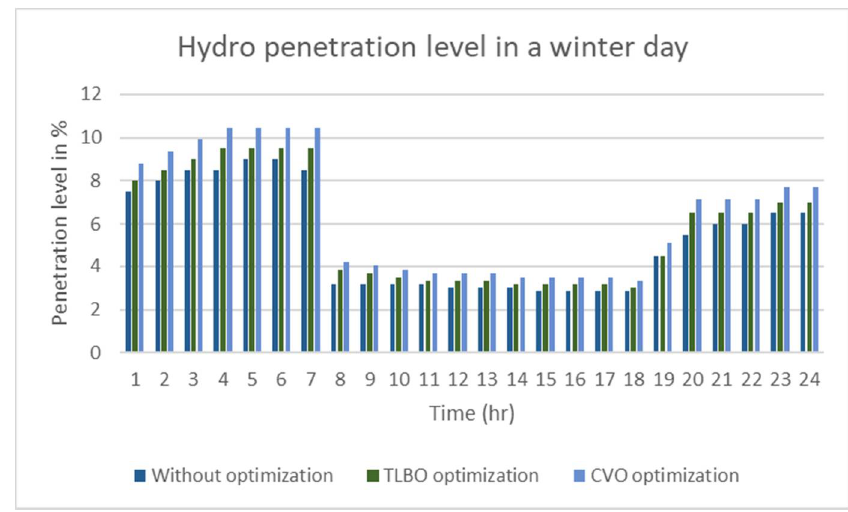
Figure 11. PV, wind and hydro penetration level in the whole grid in a winter day.